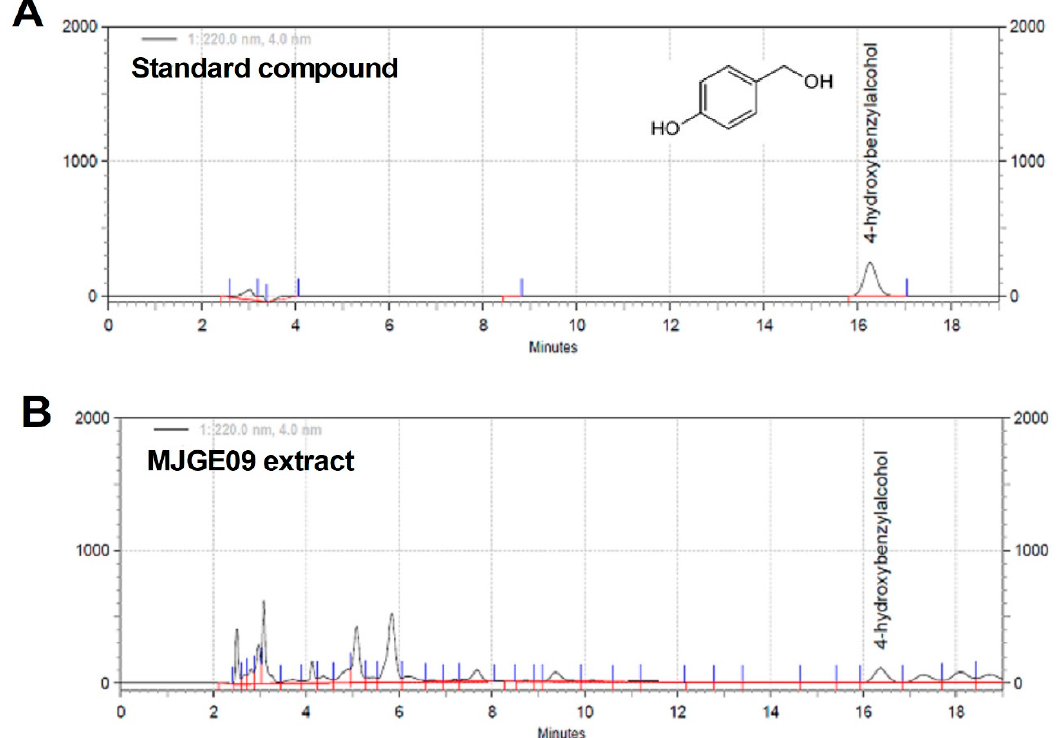
Figure 1. High-performance liquid chromatography (HPLC) analysis of the mixed extract of Gastrodia elata Blume (GE) and Zanthoxylum schinifolium Siebold & Zucc (ZS) (MJGE09). HPLC chromatograms of the standard compound ( A ) and MJGE09 extract ( B ).